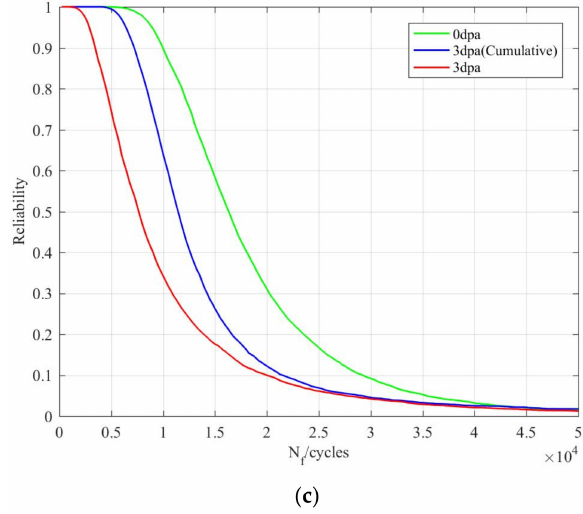
Figure 4. ( a ) Reliability curve without considering irradiation effect; ( b ) reliability curves of different neutron doses; ( c ) reliability curve considering cumulative effect of